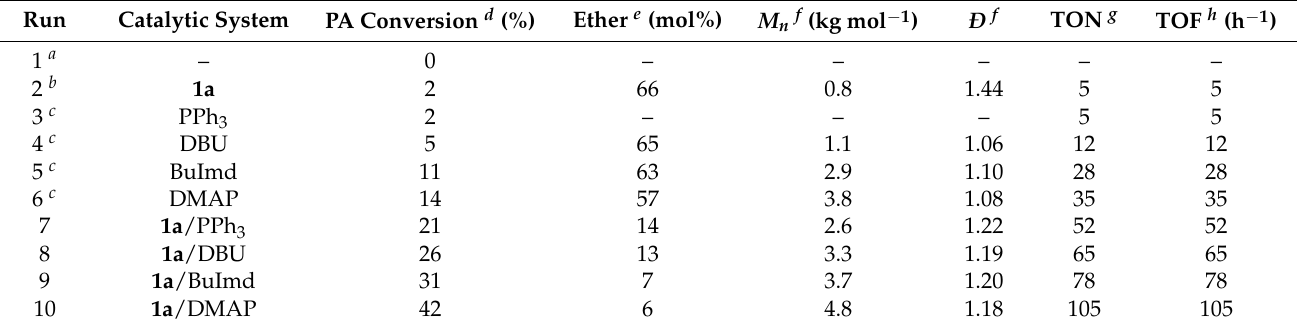
Table 1. An effect of the addition of a Lewis base on the ROCOP of phthalic anhydride (PA) with cyclohexene oxide (CHO) catalyzed by 1a